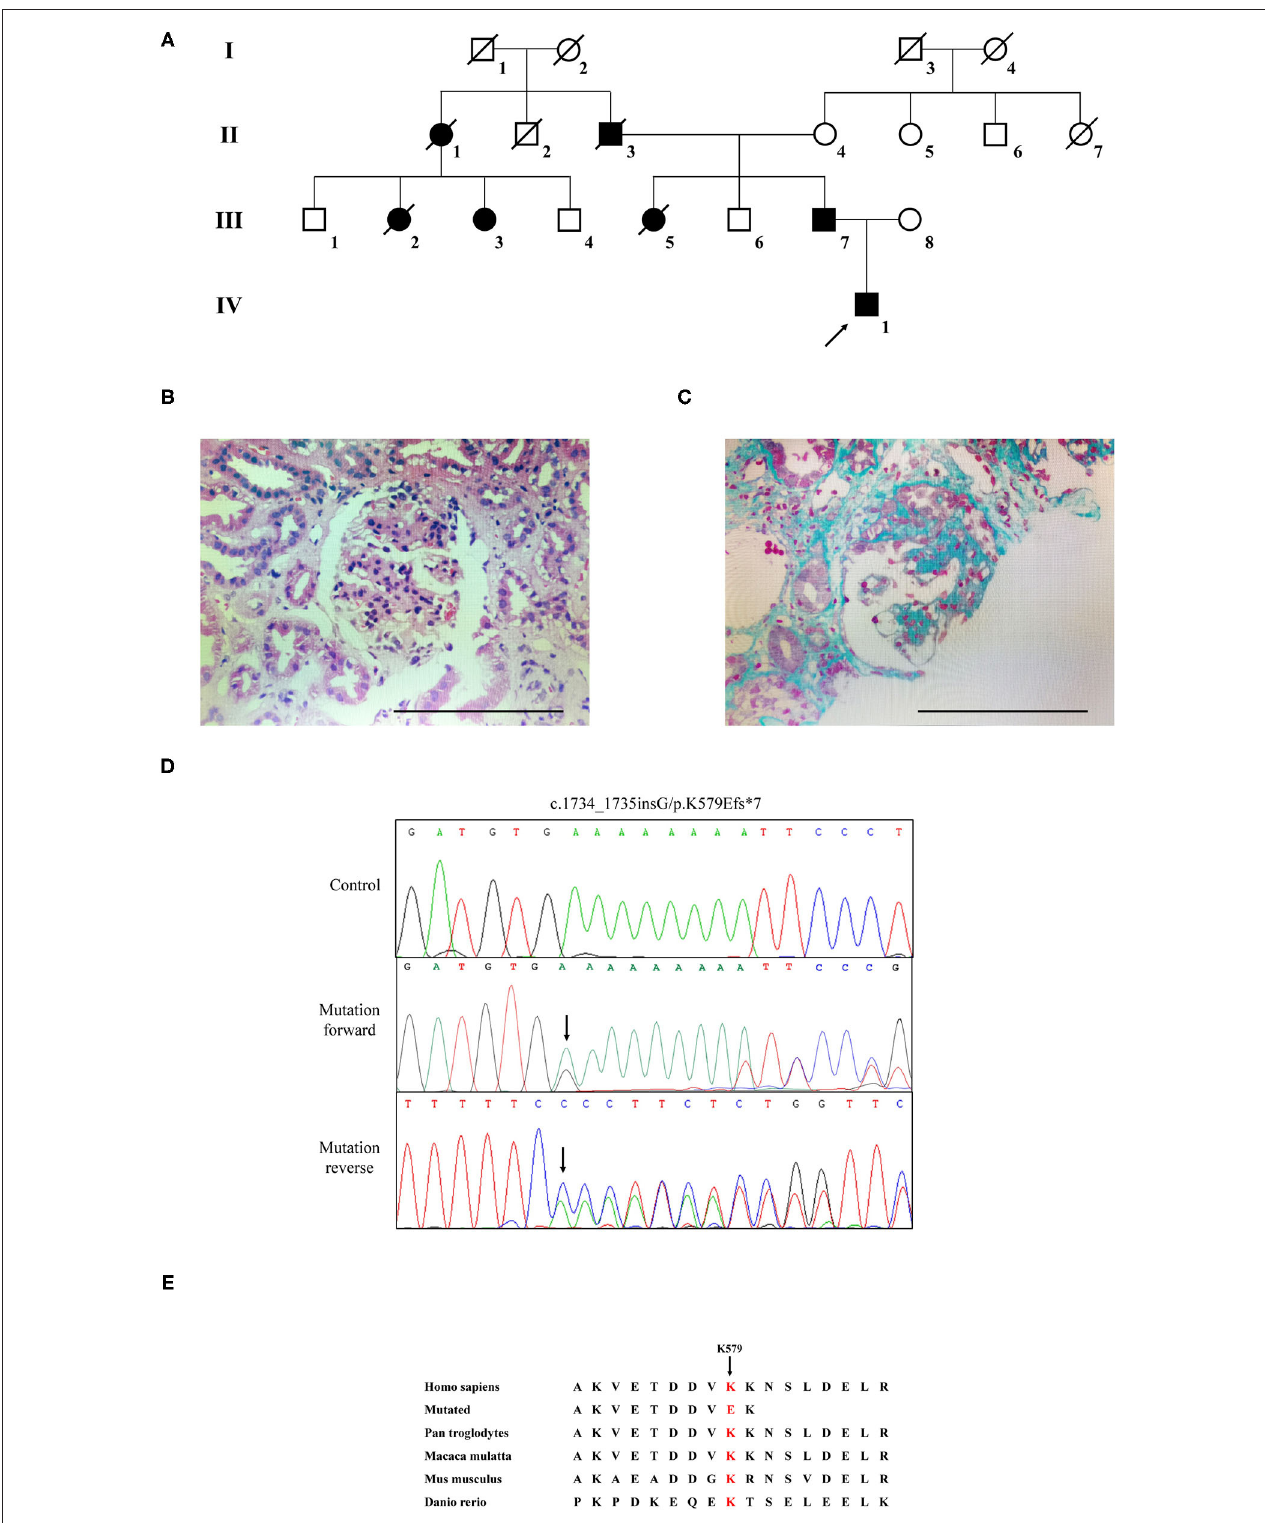
FIGURE 1 | The clinic and sequencing data of this FSGS family. (A) The pedigree of this FSGS family. Squares indicate male family members; circles, female members; black symbols, the affected members; white symbols, unaffected members; arrow, proband. (B) HE staining (C) Masson staining for renal biopsy of the proband (IV-1). (D) Sanger DNA sequencing chromatogram demonstrates a heterozygosity mutation (c.1734_1735insG/p.K579Efs*7) of CD2AP gene in affected members. (E) Alignment of multiple CD2AP protein sequences across species. Letters in red show the K579 site is evolutionarily conserved.